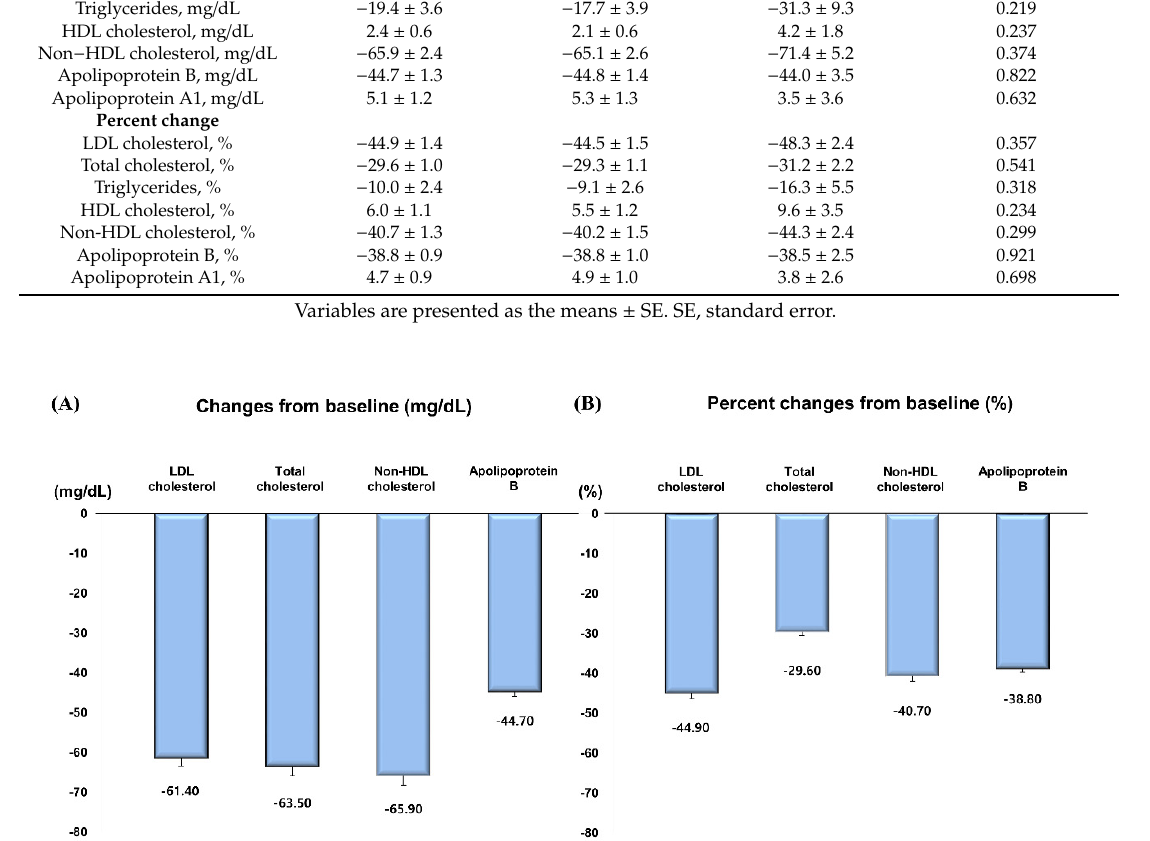
Figure 3. Changes in triglyceride, HDL cholesterol and apolipoprotein A1 in 8 weeks. ( A ) Changes from baseline. ( B ) Percent changes from baseline.